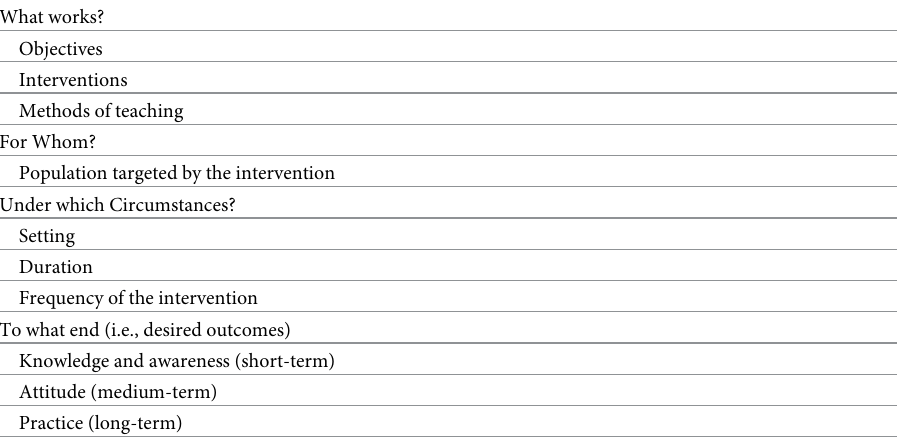
Table 1. Conceptual framework for data synthesis